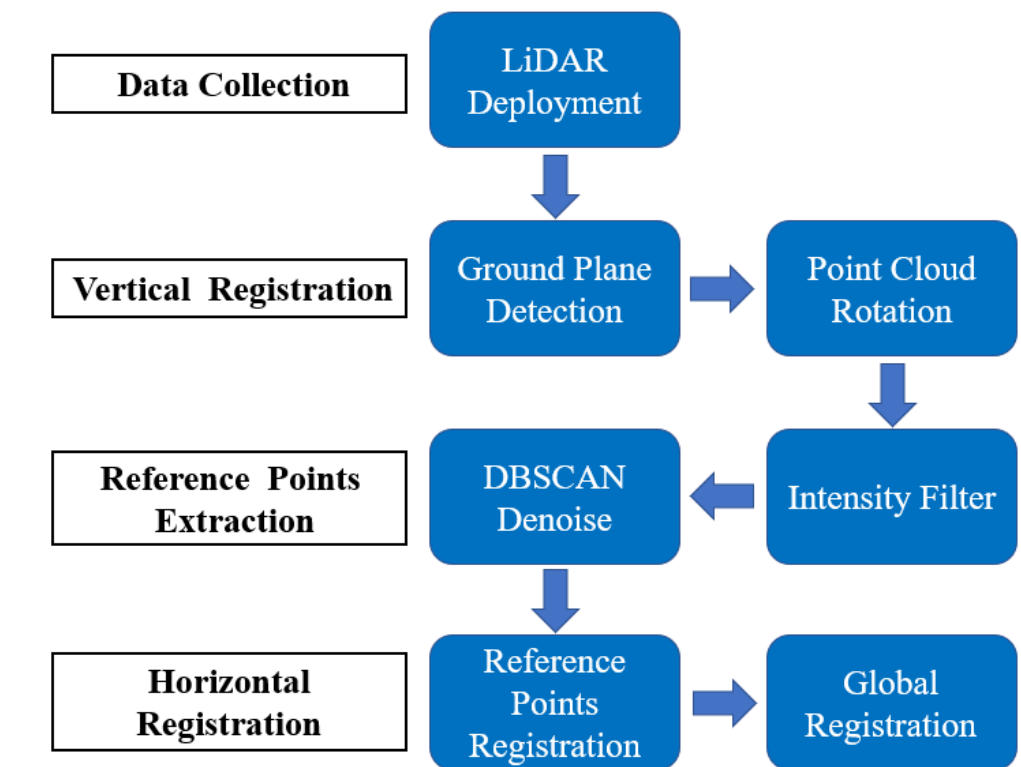
Figure 2. Algorithm flowchart.